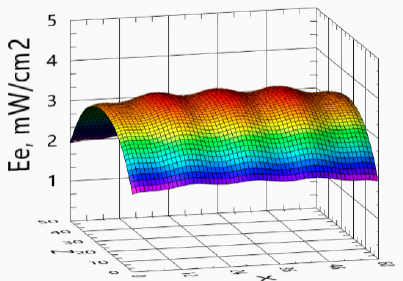
Figure 8. The spatial distribution of the direct radiation irradiance over the working area of the sterilizer.